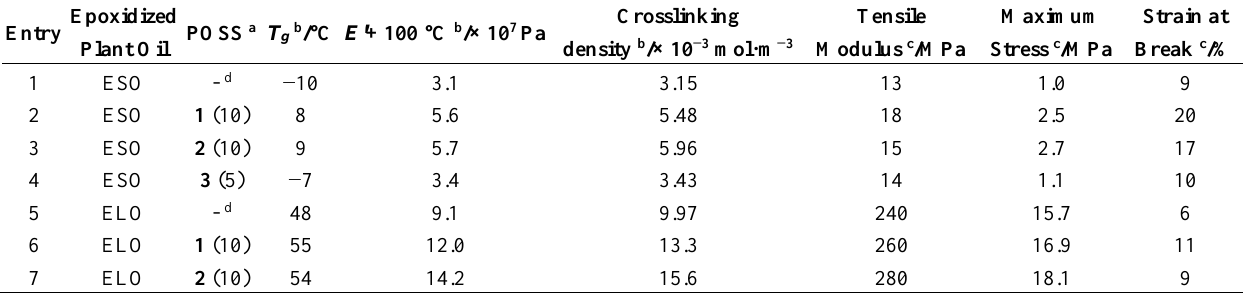
Table 2. Mechanical properties of green